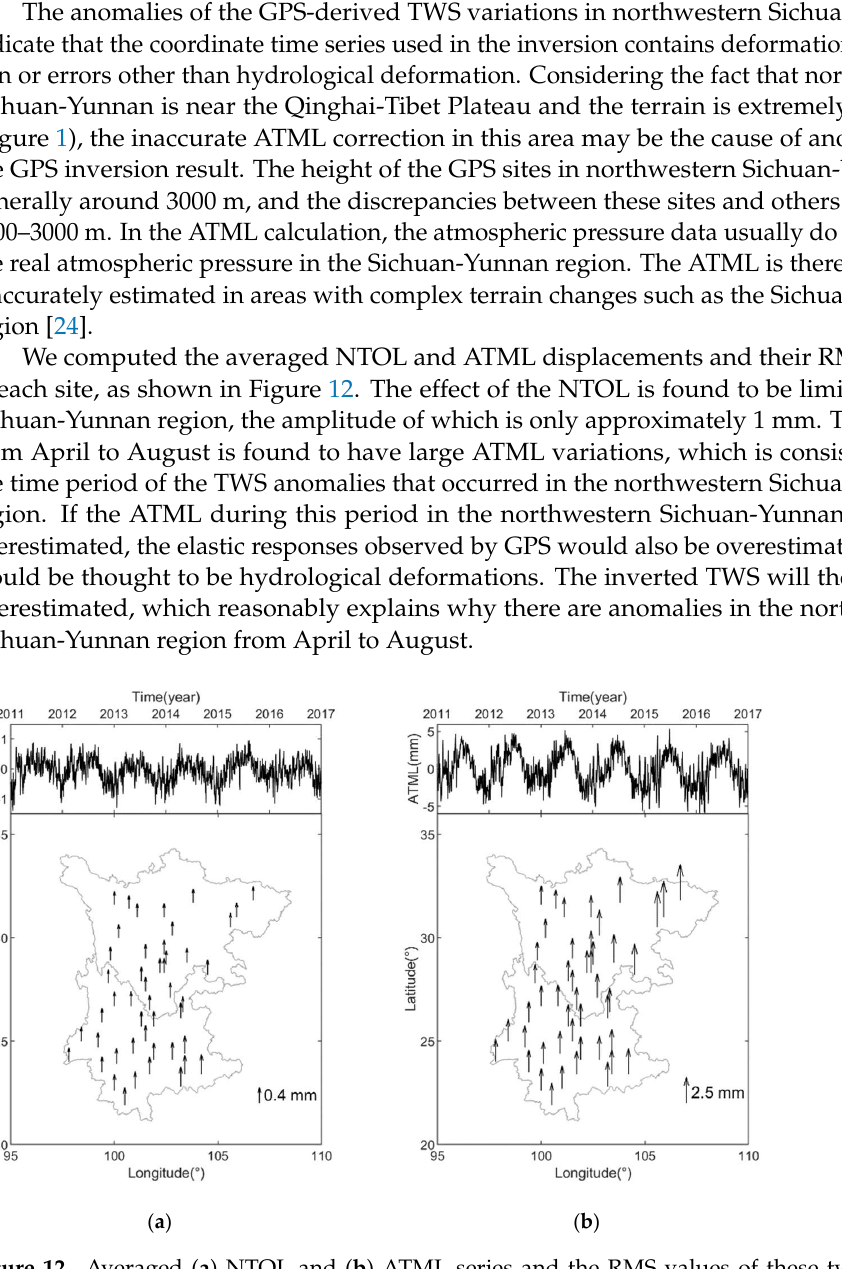
Figure 12. Averaged ( a ) NTOL and ( b ) ATML series and the RMS values of these two loading displacements for each GPS sites.